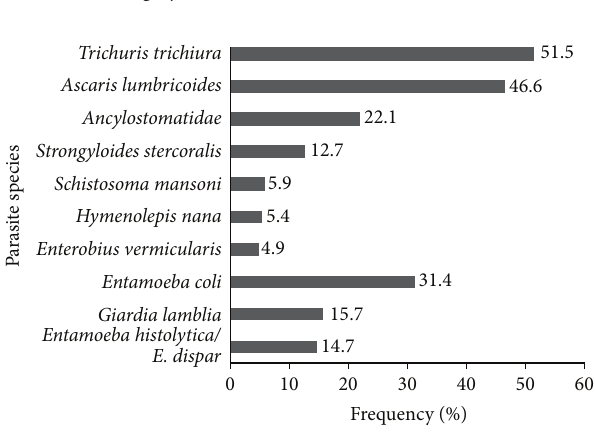
Figure 2: Frequency of parasite species identified in stool samples from children aged 0 to 15 years, living in a substandard settlement in Macei´o,